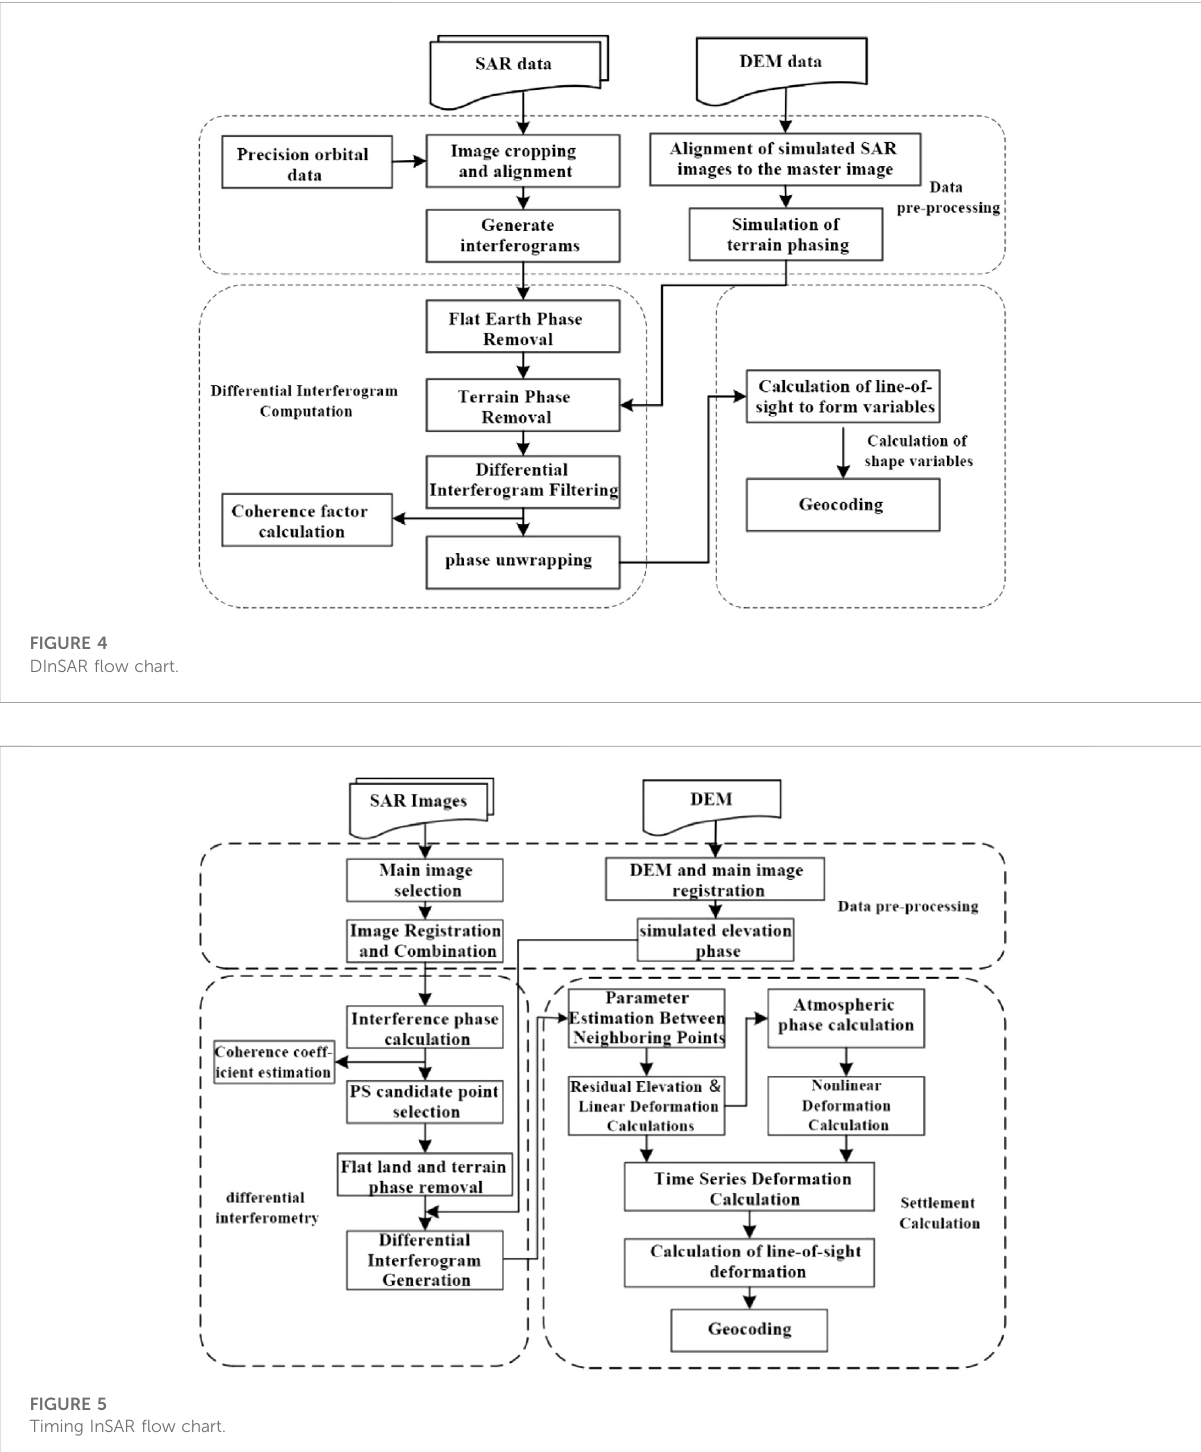
FIGURE 5 Timing InSAR fl ow